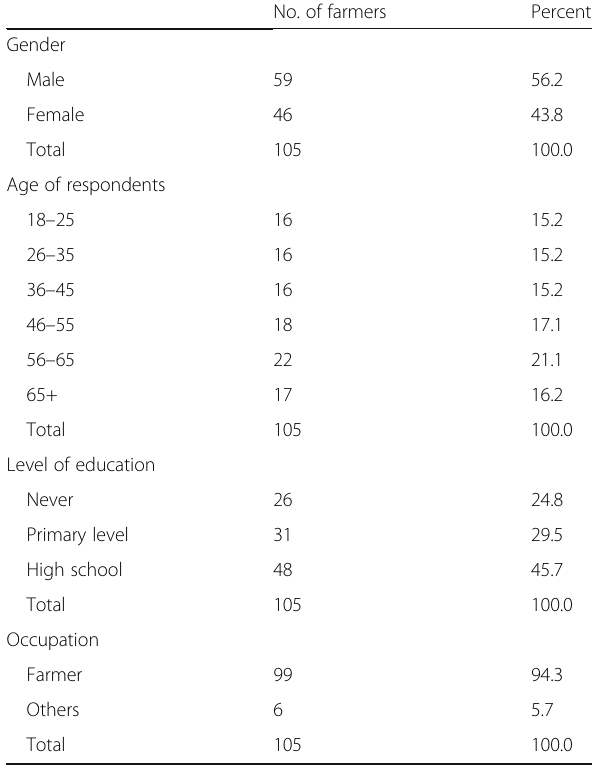
Table 1 Demographic characteristics of participants No. of